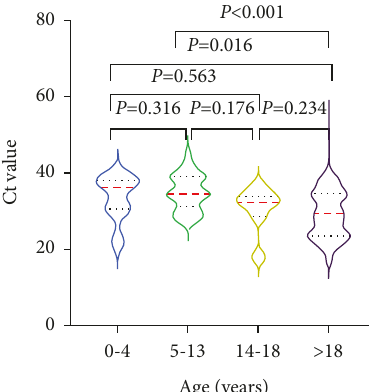
Figure 1: Ct values of nasopharyngeal nucleic acid tests in symptomatic patients stratified by